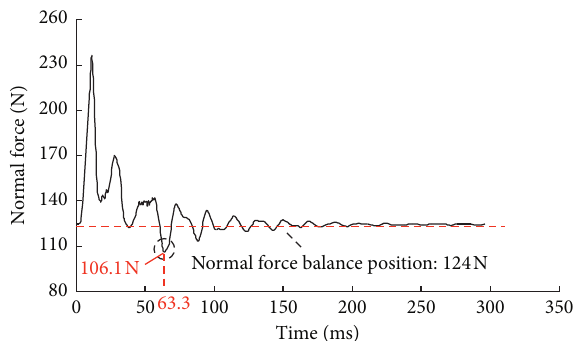
Figure 13: Time history curve of the normal force on the contact surface with the confining pressure of 10MPa.